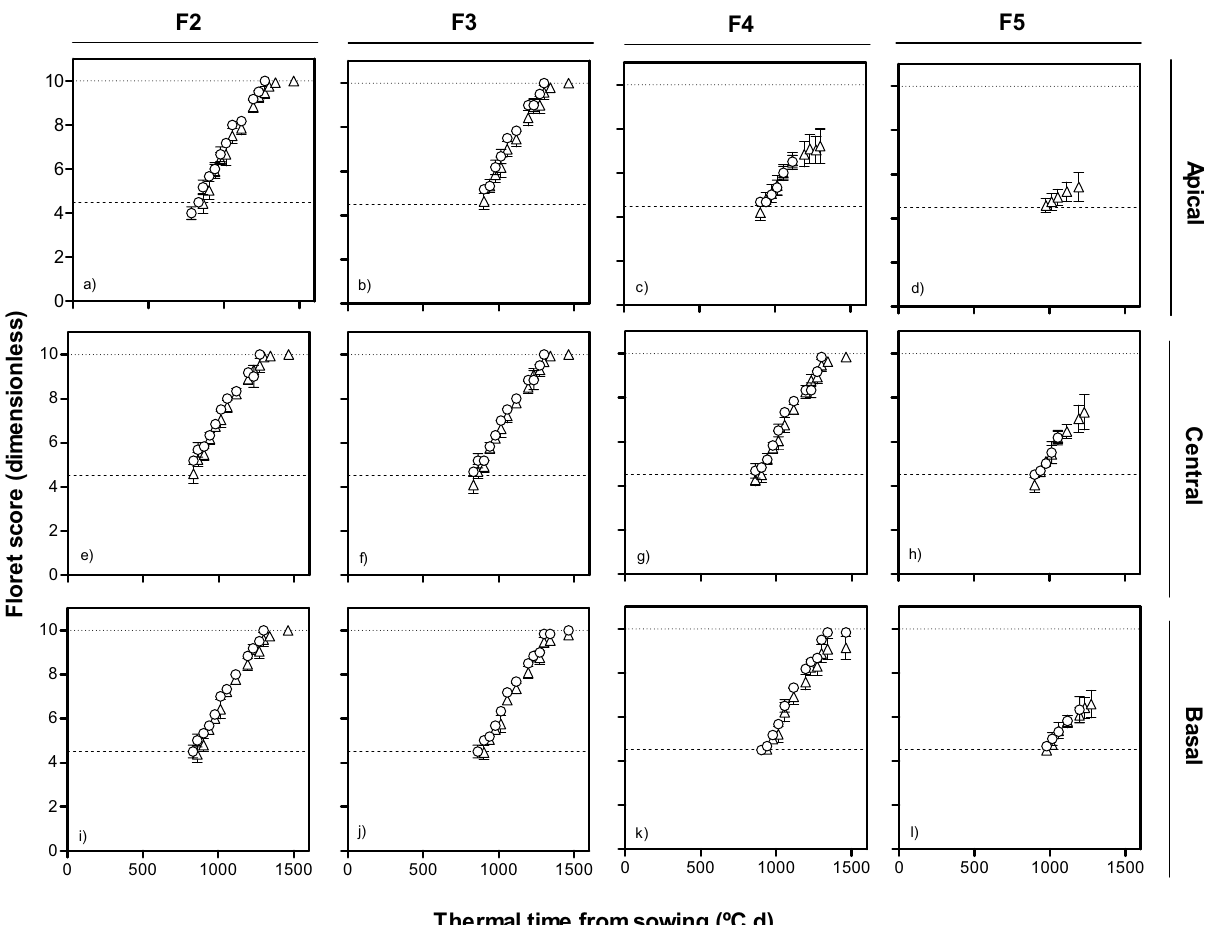
Figure 7. Dynamics of floret development (floret score) in F2, F3, F4 and F5 florets at apical (top panels: a – d ), central (middle panels: e – h ) and basal (bottom panels: i – l ) positions of the spike with thermal time from sowing in lines with Eps-2B-late (triangles) and early (circles) allele with Eps-7D-late allele in the background in first cropping